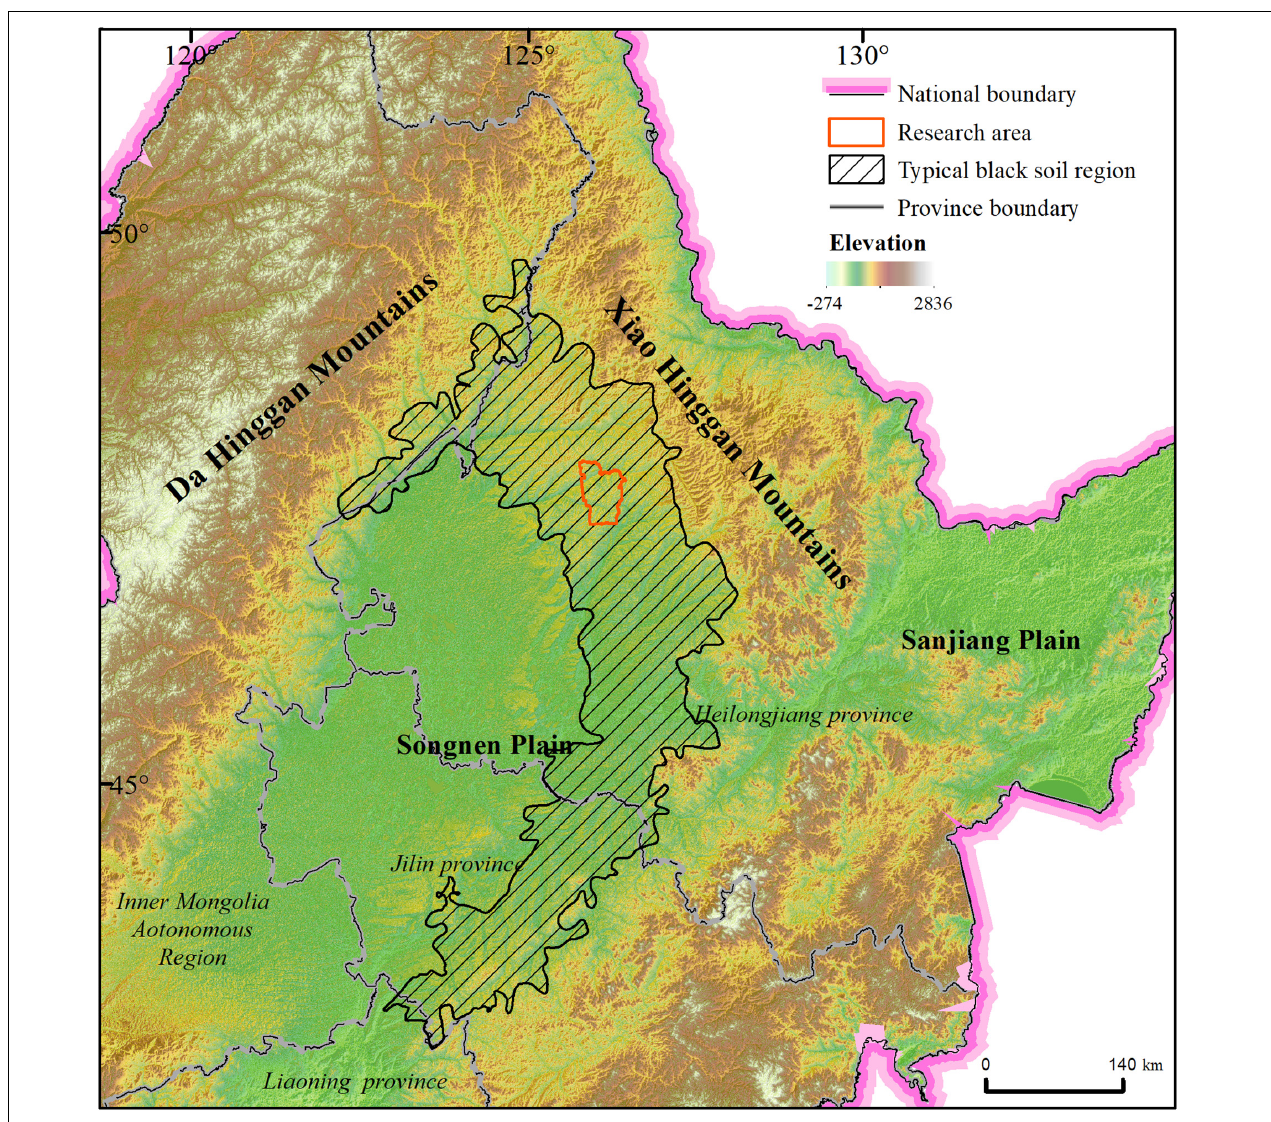
FIGURE 1 | Study area location in Northeast